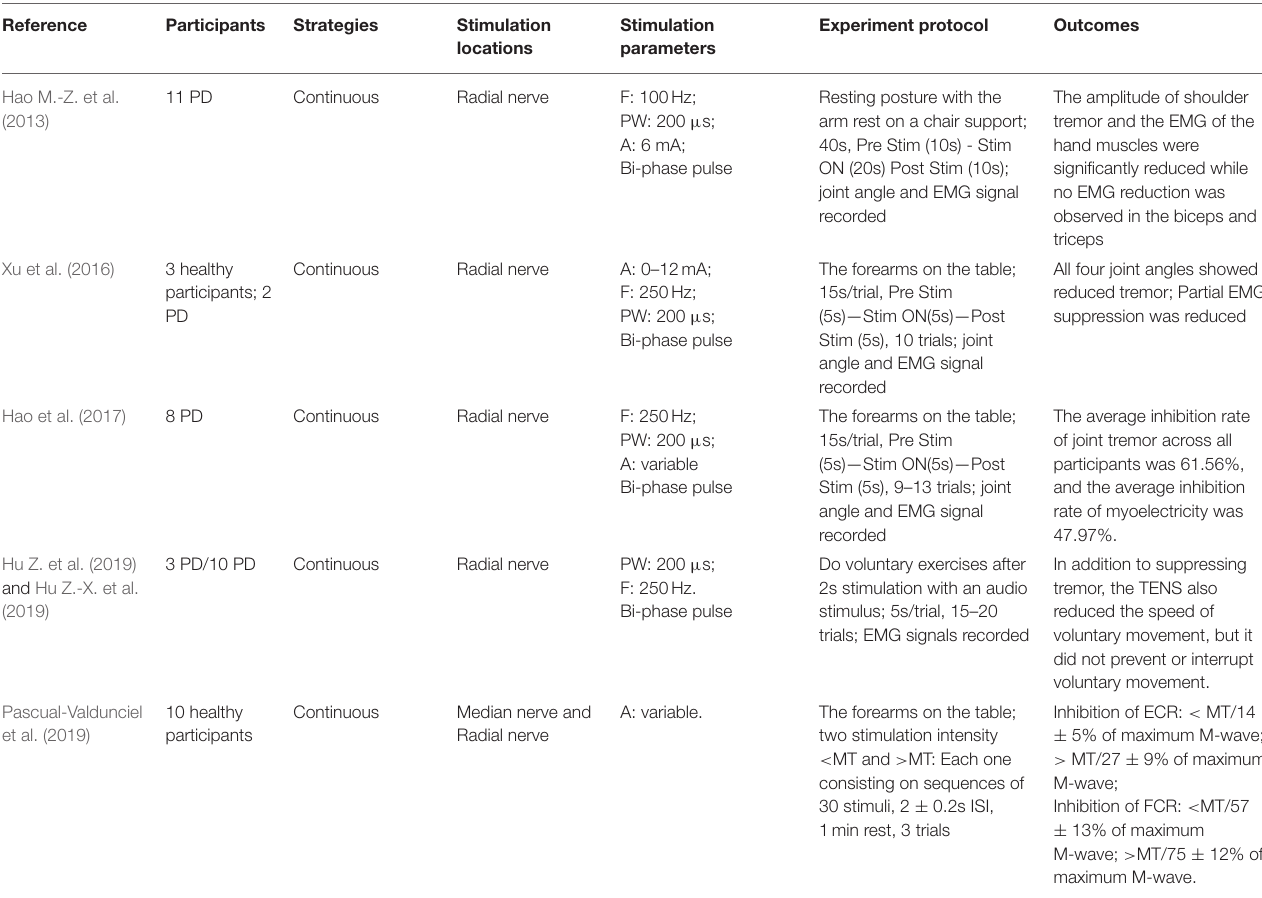
TABLE 3 | Summary of the methodologies and outcomes of transcutaneous electrical nerve stimulation (TENS). Reference